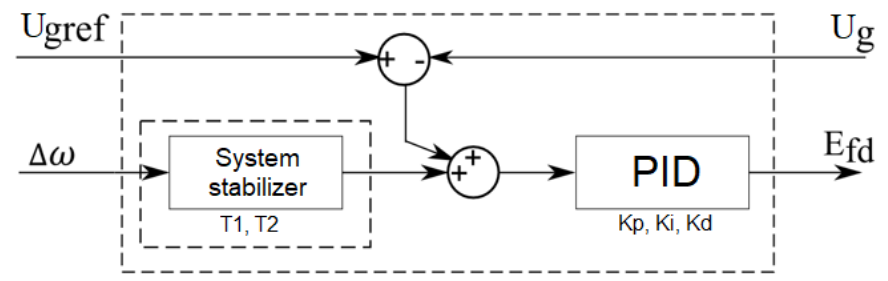
Figure 8. Structure of PID with a simple system